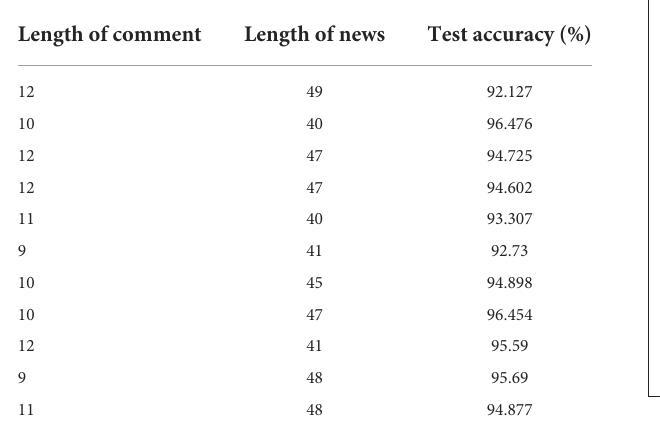
TABLE 3 Sentence length parameter debugging.